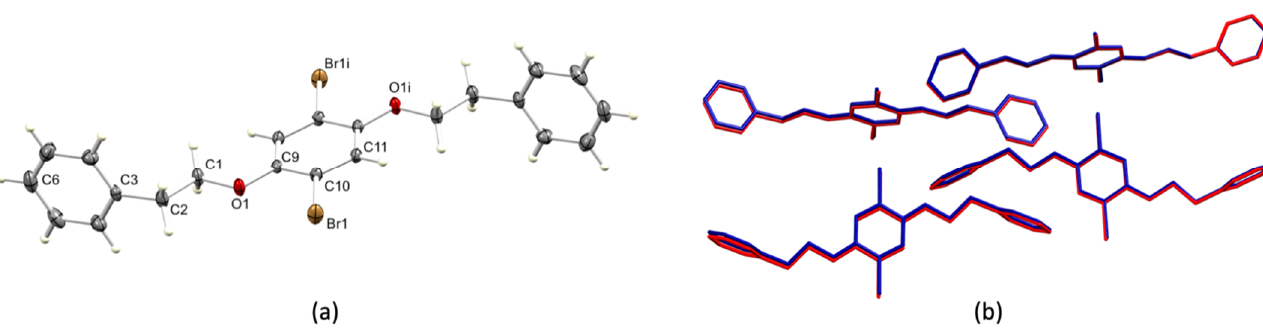
Figure 8. ( a ) Molecular structure of 1 , polymorph II (orthorhombic) with ellipsoids at 40% probability level. Symmetry code i: 1 − x , 1 − y , 1 − z . Selected bond parameters: C10–Br1 = 1.889(2), C9–O1 = 1.363(3), C1–O1 = 1.429(3) Å; C1–O1–C9 = 117.92(17)°. ( b ) Overlay of the four independent molecules of polymorph I of 1 (in red), and the molecule of polymorph II of 1 with additional symmetry-generated molecules; H atoms are omitted for clarity.